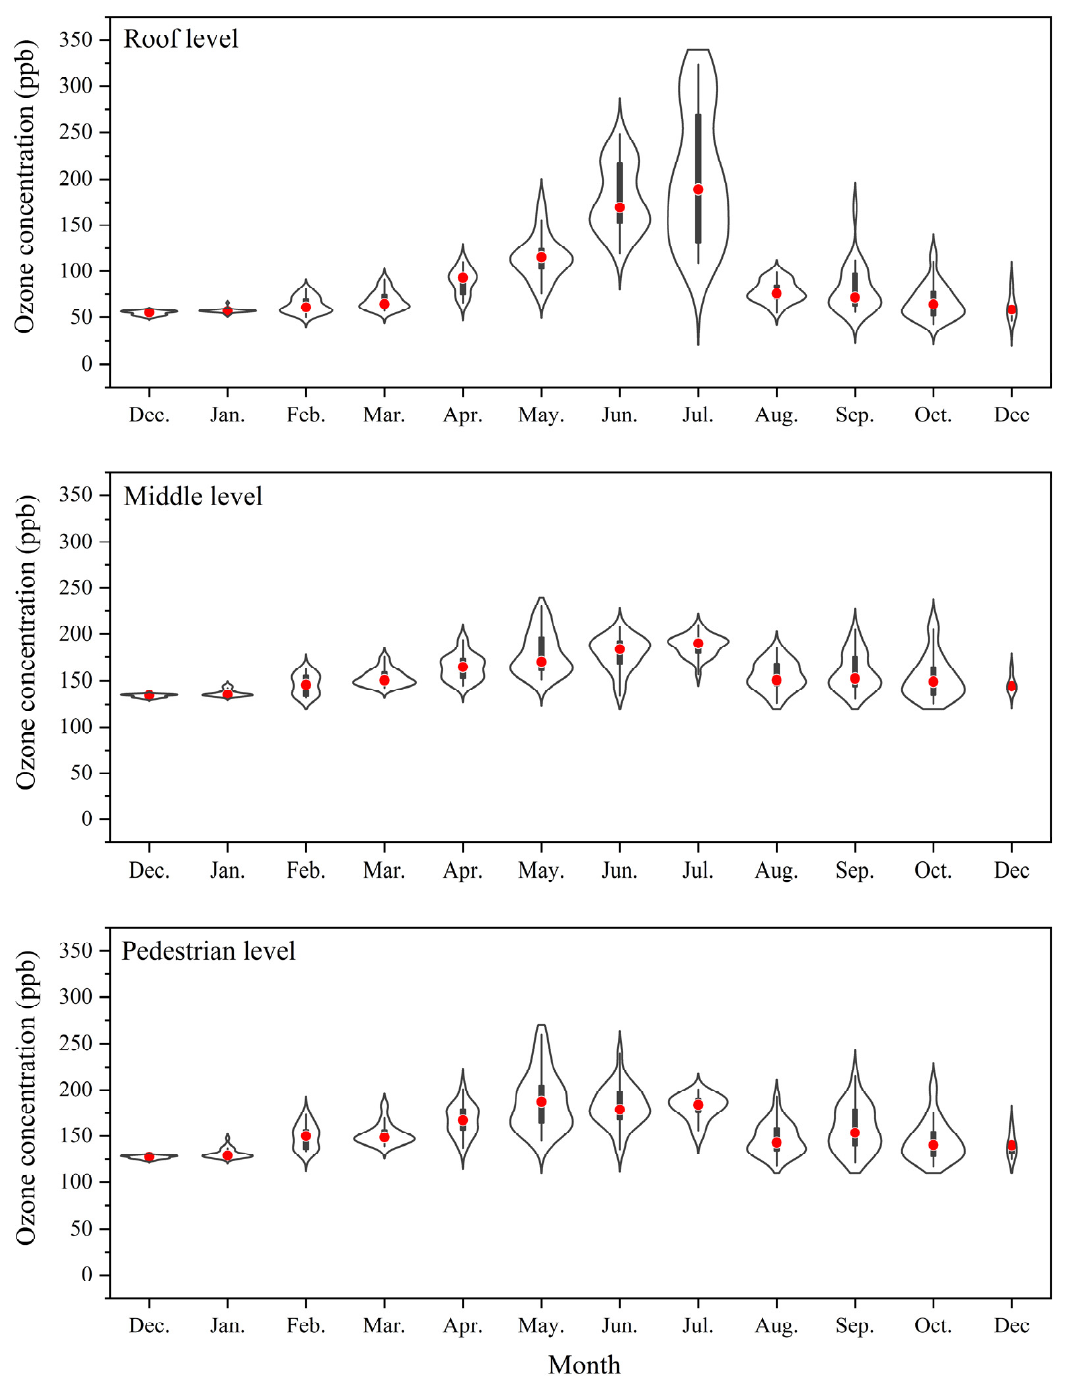
Figure 2. Violin plots showing monthly variations of O 3 concentration in the street canyon at three levels: pedestrian level, middle level, and roof level.